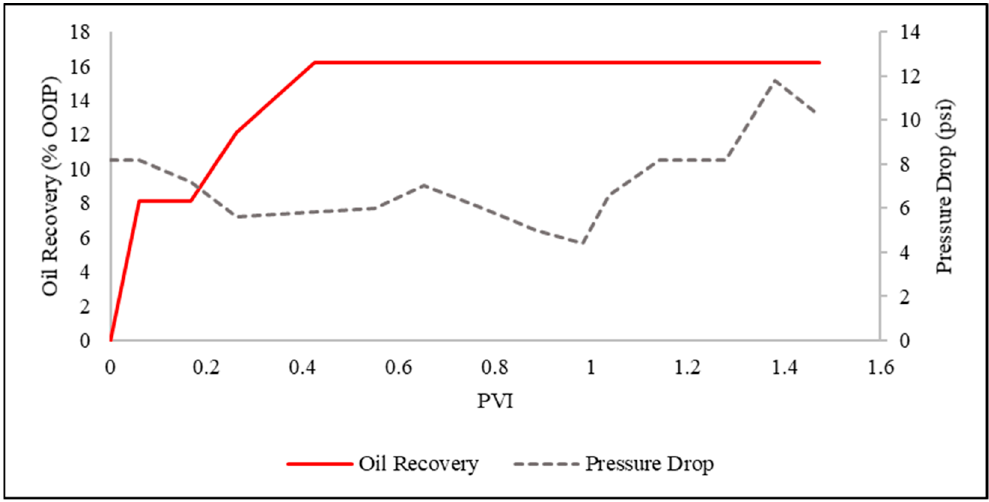
Figure 11. Oil recovery and pressure response for the Copper Ridge dolomite immiscible CO 2 flood.